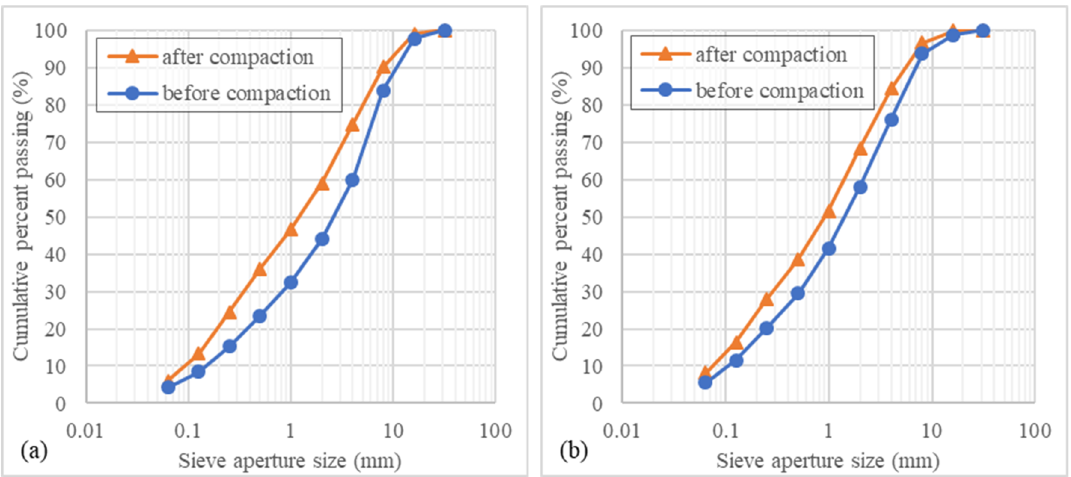
Figure 5. Particle size distribution of red scoria ( a ) and black scoria ( b ) before and after compaction.